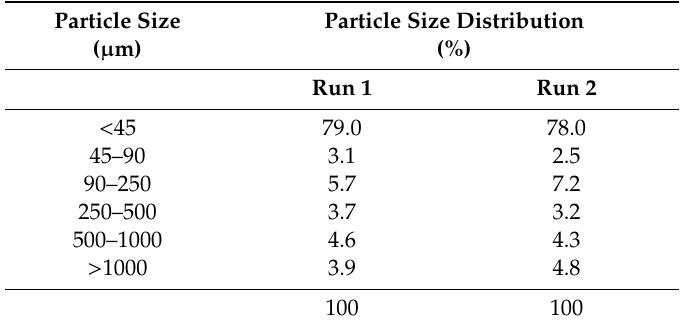
Table 2. Particle size distribution of mixed manure (wet